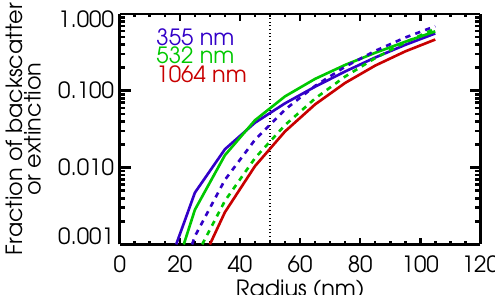
Figure 11. The effect on the backscatter coefficient (solid lines) and extinction coefficient (dashed lines) of 1000cm − 3 particles in a narrow mode ( s = 1.48) with varying median radius, expressed as a fraction of the backscatter and extinction measured in a typical ob- servation by HSRL-2 on 17 July 2012 during the TCAP campaign. The dotted line indicates the 50nm particle radius cutoff discussed in the text.